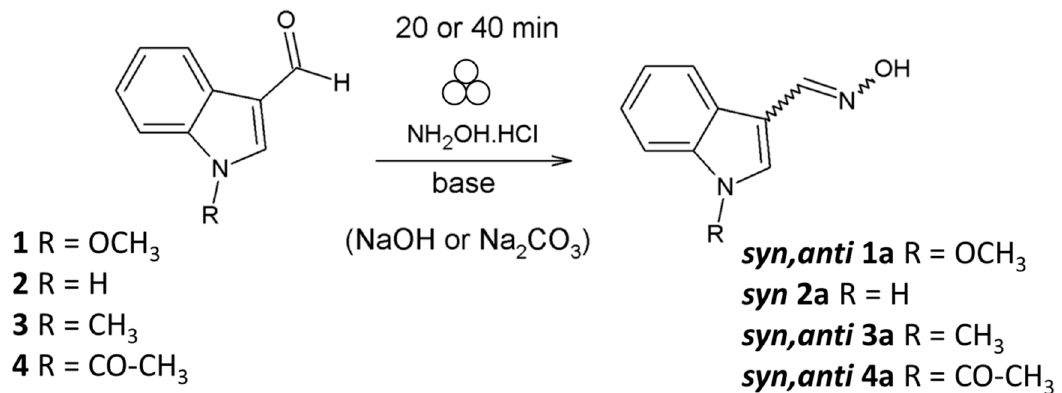
Table 1. Basic experimental conditions used in the synthesis of 1-methoxyindole-3-carboxaldehyde oxime and the reactions outcome . The different reaction conditions are marked by color: green color: ball milling in Pulverisette 7 premium line mill, WC vessel (80 mL) and balls (in most cases 18